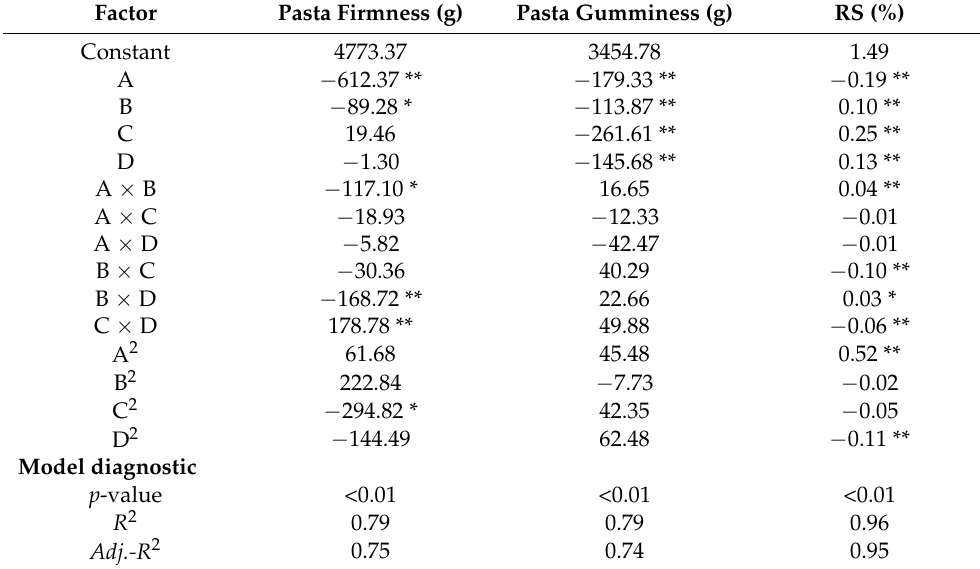
Table 4. ANOVA results for quadratic model fitted to cooked pasta parameters.